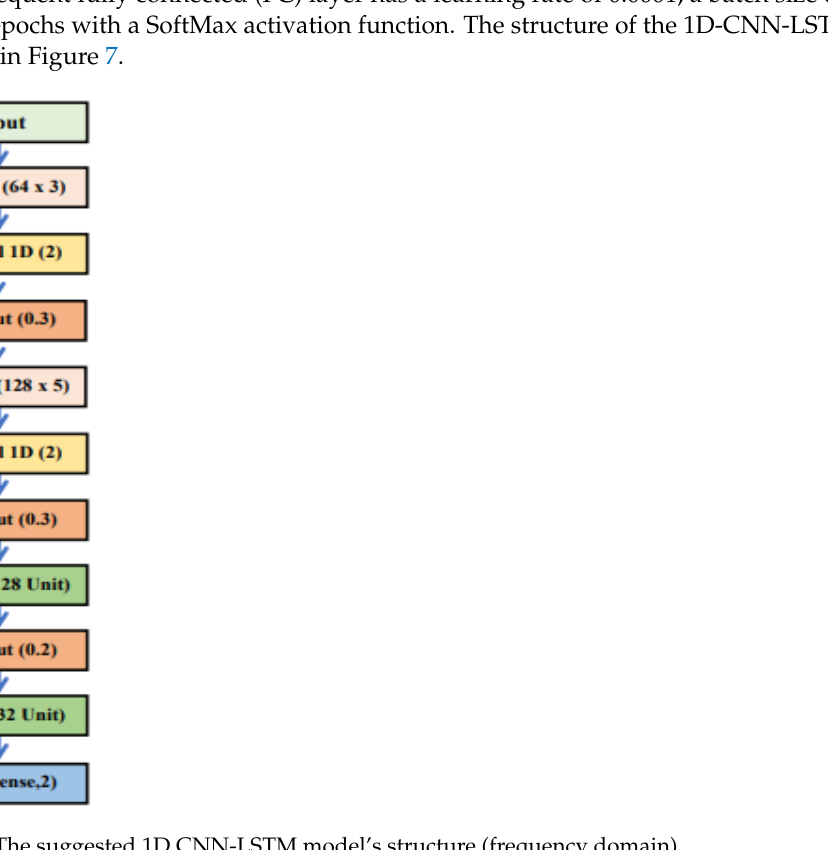
Table 4. The samples of datasets for corona and non-corona in the frequency domain. No Name of Samples No of Samples 1 Arcing faults 53 ∗ 10,001 Corona faults 39 ∗ 10,001 Tracking faults 40 ∗ 10,001 Mechanical faults 16 ∗ 10,001 Normal faults 12 ∗ 10,001 The 1D-CNN-LSTM model structure consists of two global max pooling layers and two 1D convolution layers. To save processing time, a dropout of 0.3 is employed after each layer from the global max pooling layers, with RELU activation used for the CNN layers.